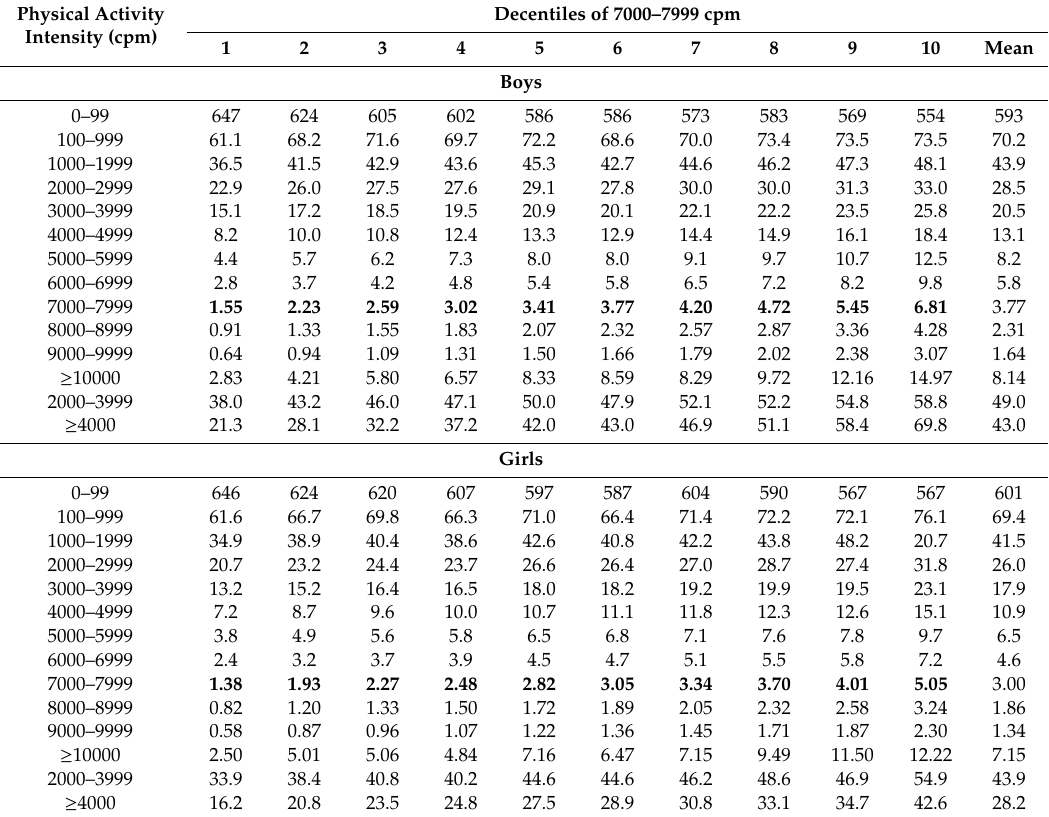
Table 4. Mean time (min / day) spent in PA intensities according to decentiles of time spent in 7000–7999 cpm.